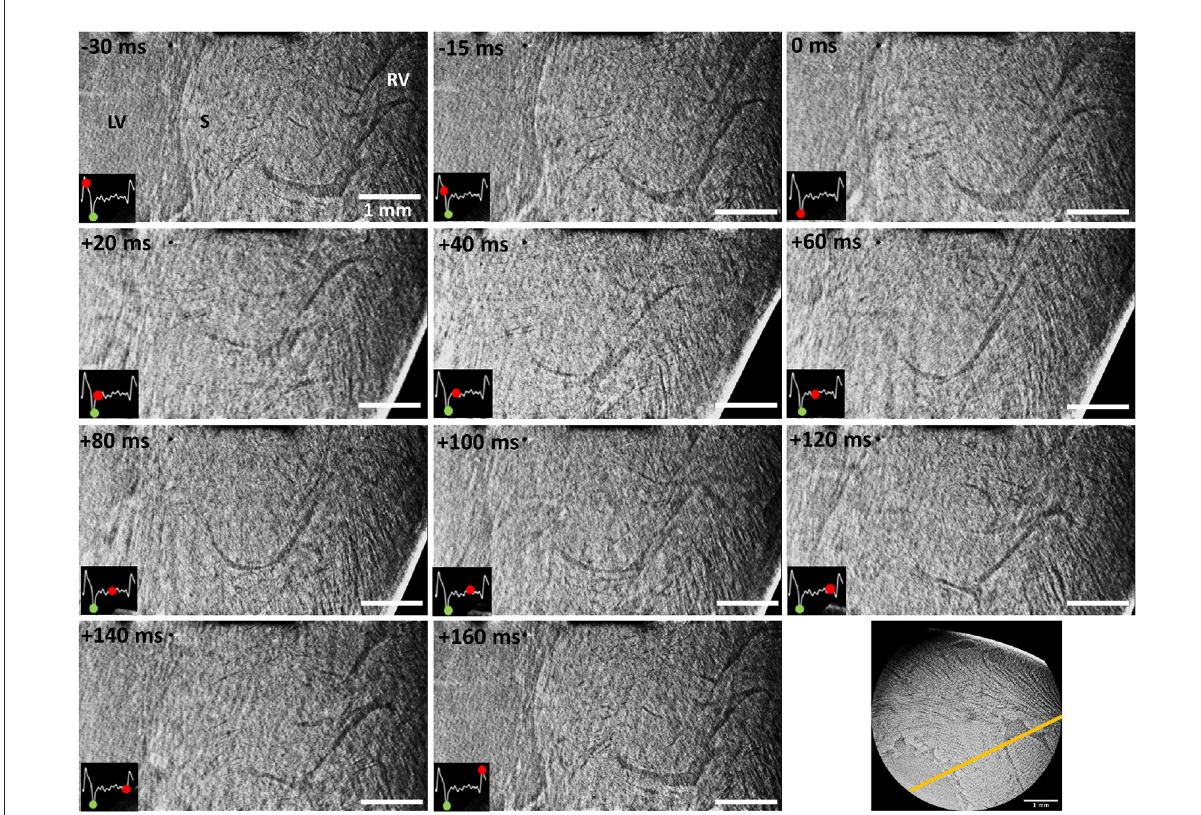
FIGURE4 Time-series of an illustrative reslice (see bottom right, yellow line) from the scanned region including part of the left ventricular chamber (LV), septum (S) and right ventricular wall (RV). Time is indicated using the start of the contraction as reference (0 ms). An ECG signal corresponding to a full heartbeat is included in every slice. The green dot on the ECG indicates the start of the contraction (reference time-point), while the advancing red dot corresponds to the exact reconstruction location. Scale bar is 1